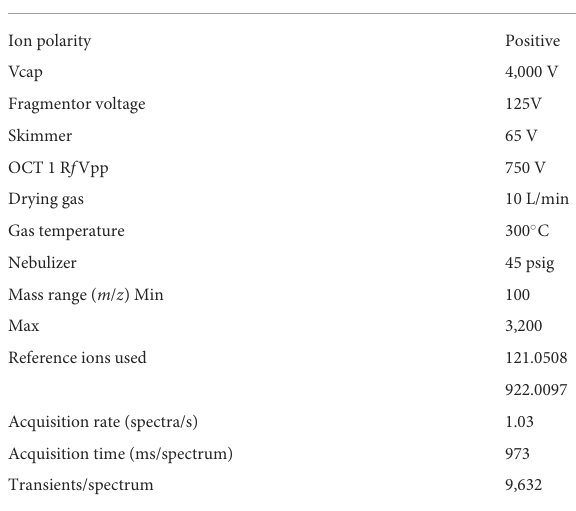
TABLE 1 Tuning parameter of liquid chromatography-mass spectrometry